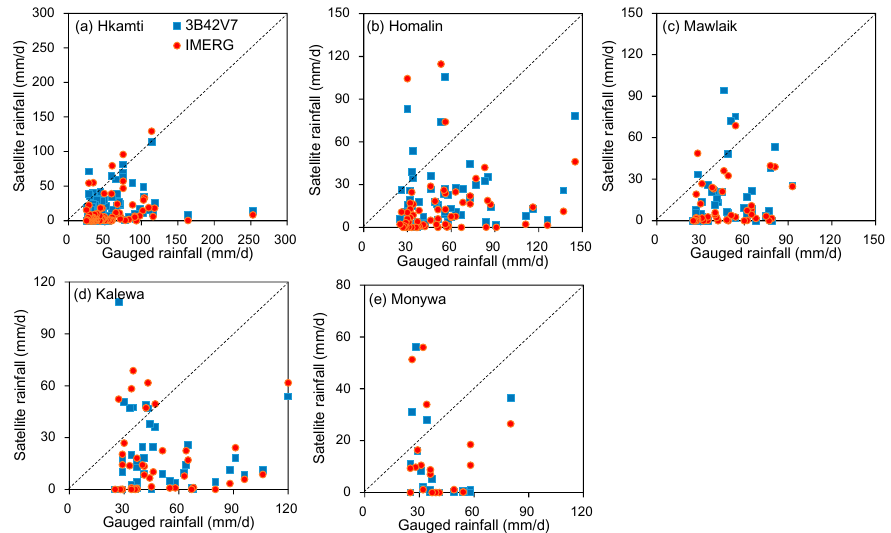
Figure 5. Scatter plots of heavy precipitation events from 3B42V7 and IMERG precipitation products against gauged precipitation data at the five weather stations in the Chindwin River basin (1 April 2014–31 December 2015). Table 3. Statistical indices of satellite precipitation estimates of heavy and light rain events at the five weather stations in the Chindwin River basin (1 April 2014–31 December 2015). Weather Stations Satellite Precipitation